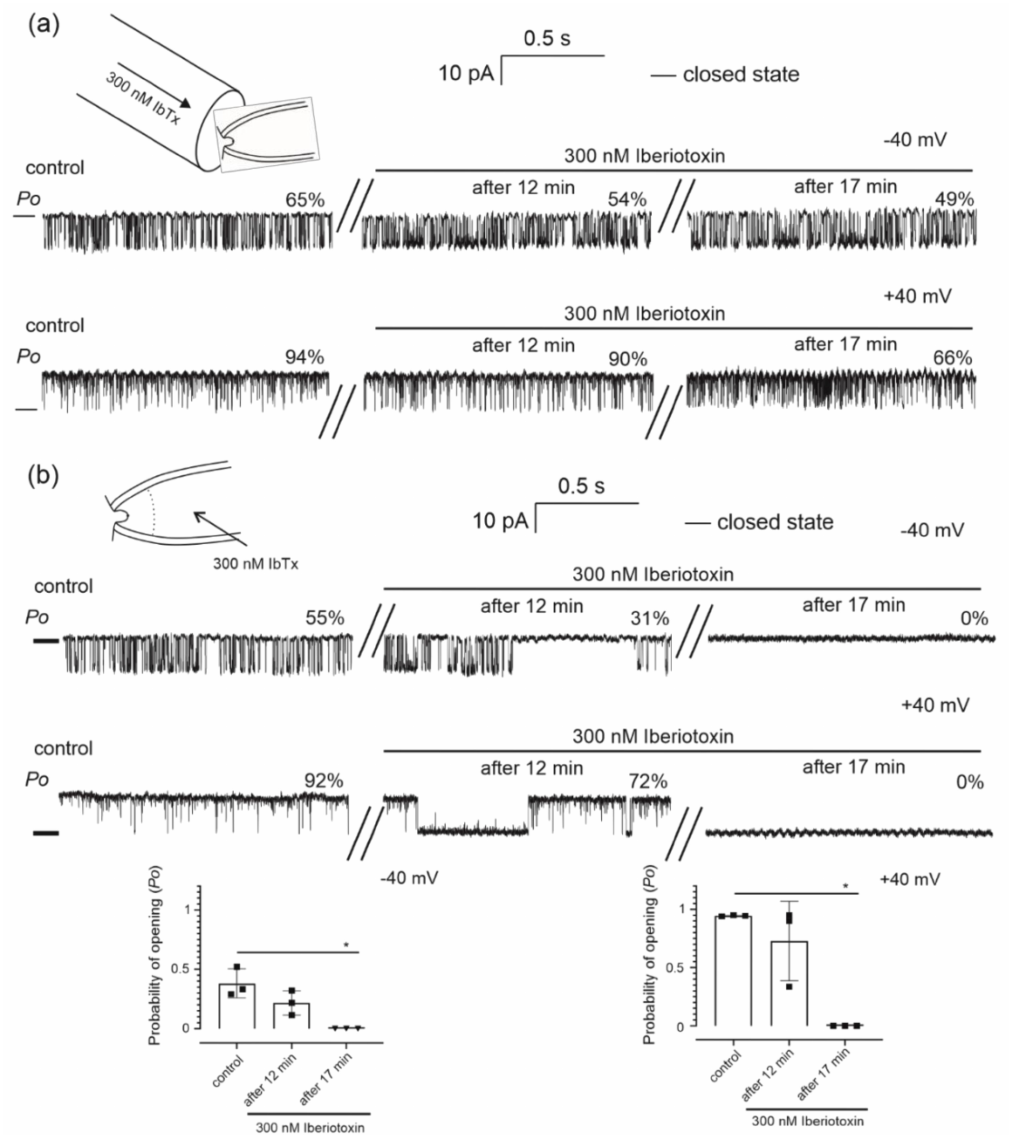
Figure 5. Effect of iberiotoxin on mitoBK Ca channel activity. ( a ) Scheme of the mitochondrial matrix direction of iberiotoxin administration to the mitoBK Ca channel with control activity. Representative single-channel current-time recordings of the mitoBK Ca channel incubated with 300 nM iberiotoxin ( n = 3) for different times at − 40 mV and +40 mV. ‘—’ indicates a closed channel state. The Po analysis (%) of single channel events is shown. ( b ) Scheme of the intermembrane space direction of iberiotoxin administration to the mitoBK Ca channel with control activity. Representative traces showing the effects of the time of incubation with 300 nM iberiotoxin ( n = 3) recorded at − 40 mV and +40 mV. “ — ” indicates a closed channel state, and the Po analysis (%) of single channel events is shown. The charts below show the quantification of the mitoBK Ca channel open probability in the presence of the control (100 µ M Ca 2+ ) and 300 nM iberiotoxin after different incubation times. p < 0.05